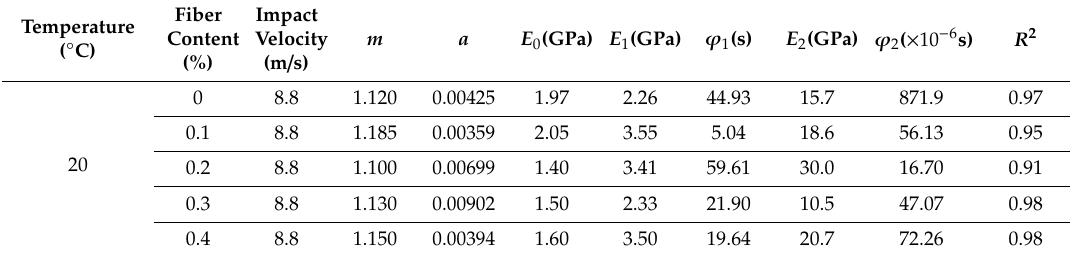
Table 5. Inversion results of ZWT model parameters under different conditions.